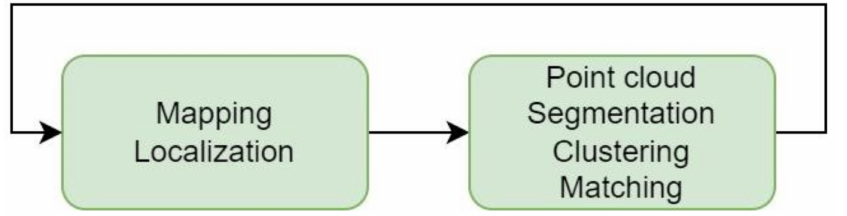
Figure 16. Process of dynamic objects detection.